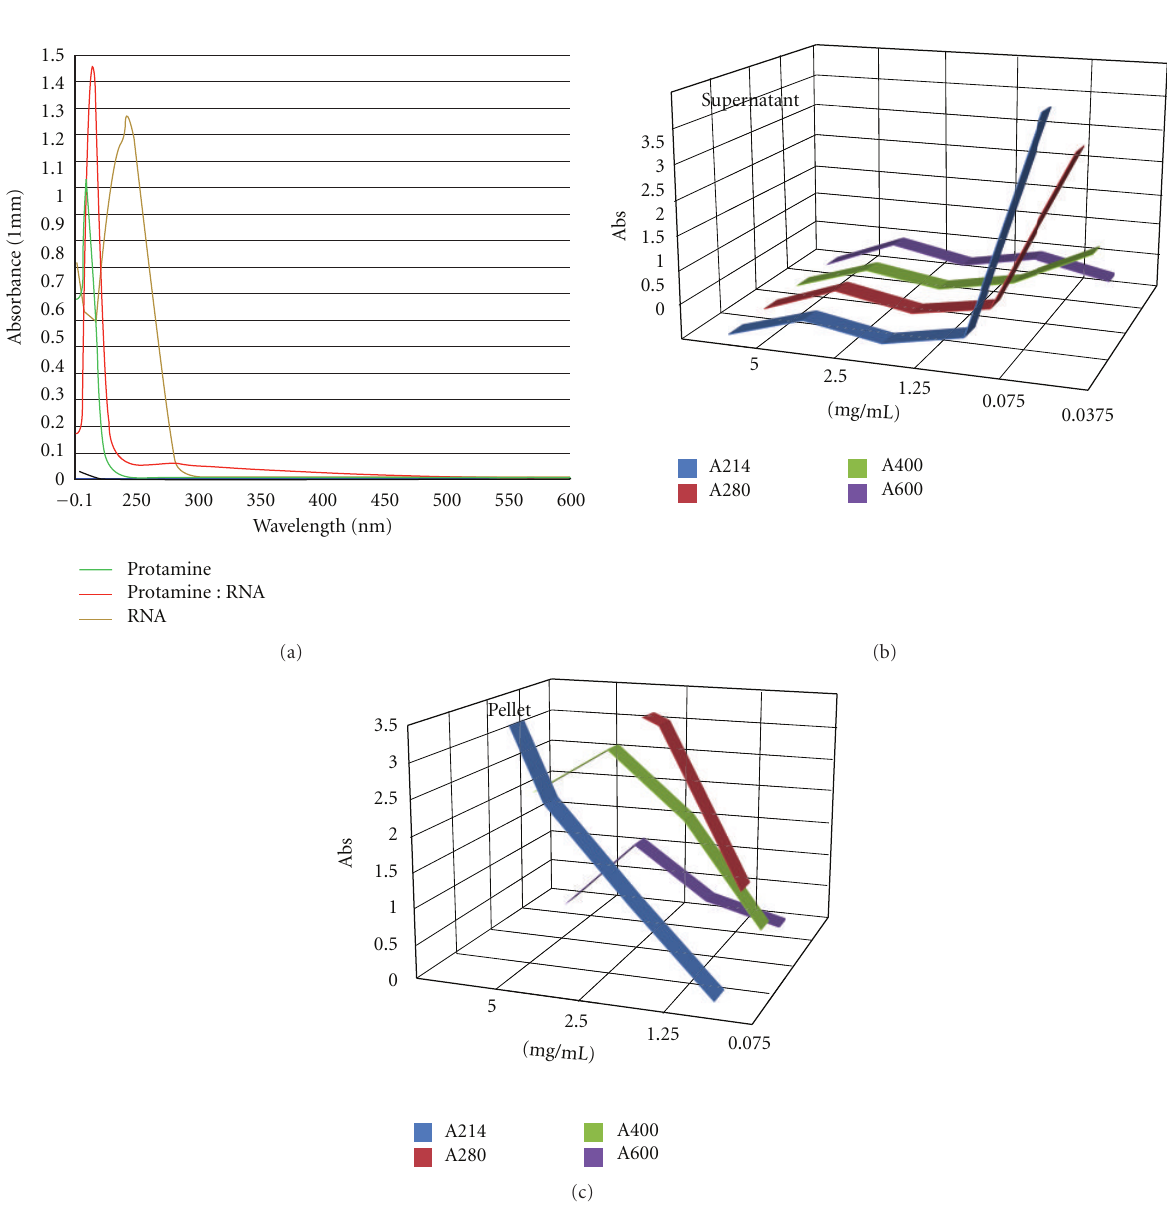
read; the samples were centrifuged, followed by another absorbance reading of the supernatant, as stated